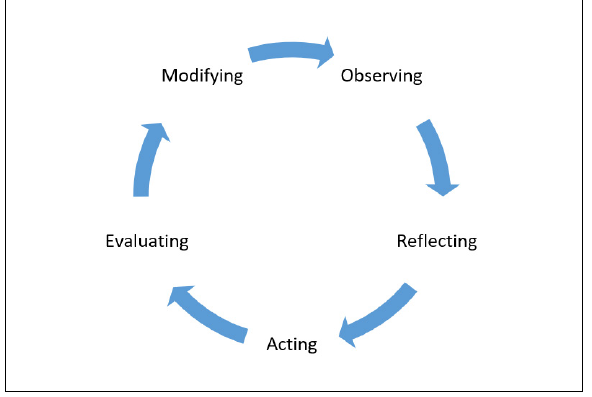
Figure 1: Lewin’s cycle of participatory action research. 15